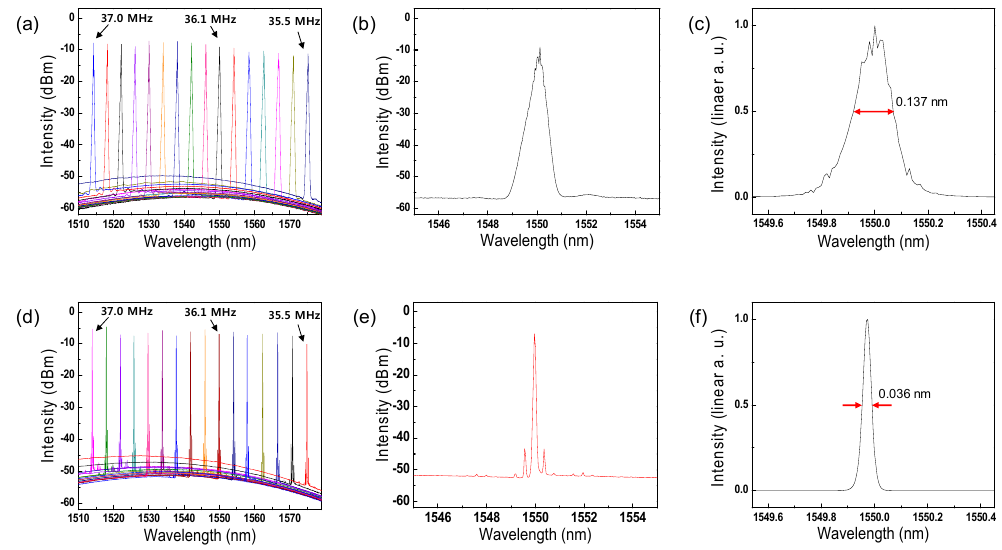
Figure 3. ( a – c ) Conventional WSL with AOTF; ( d – f ) proposed WCSL with AOTF. ( a , d ) Static output spectra for various RF signal; ( b , e ) dB-scale spectra at 1550 nm for shape monitoring; ( c , f ) linear-scale spectra at 1550 nm for linewidth measurement.